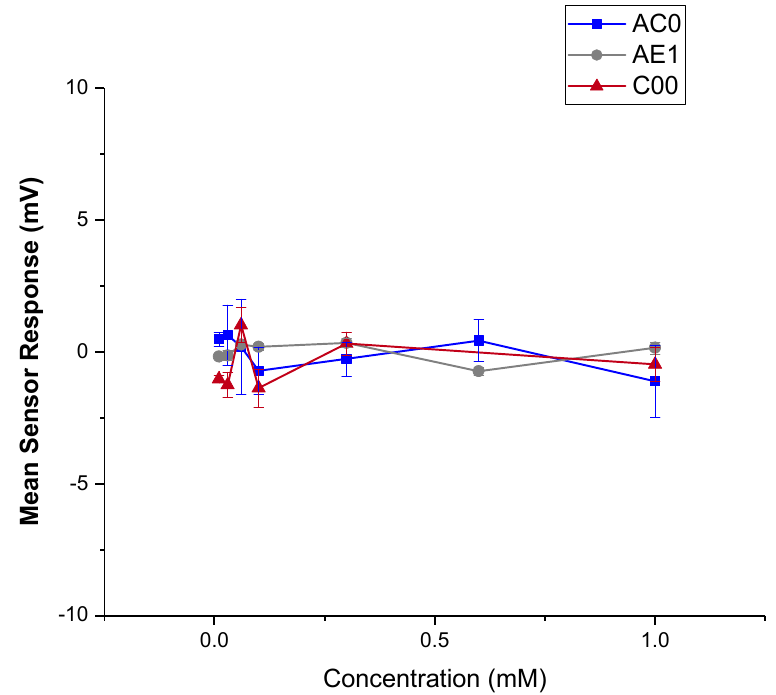
Figure 12. Sensor response curve of pure CBZ in 10 mM KCl (with 10% v / v ethanol); Mean responses of the AC0, AE1 and C00 sensors reflecting initial taste.